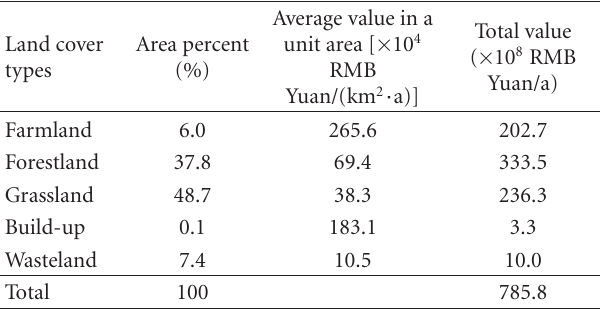
Table 3: Economic value of avoided reservoir sedimentation of di ff erent types of land cover in